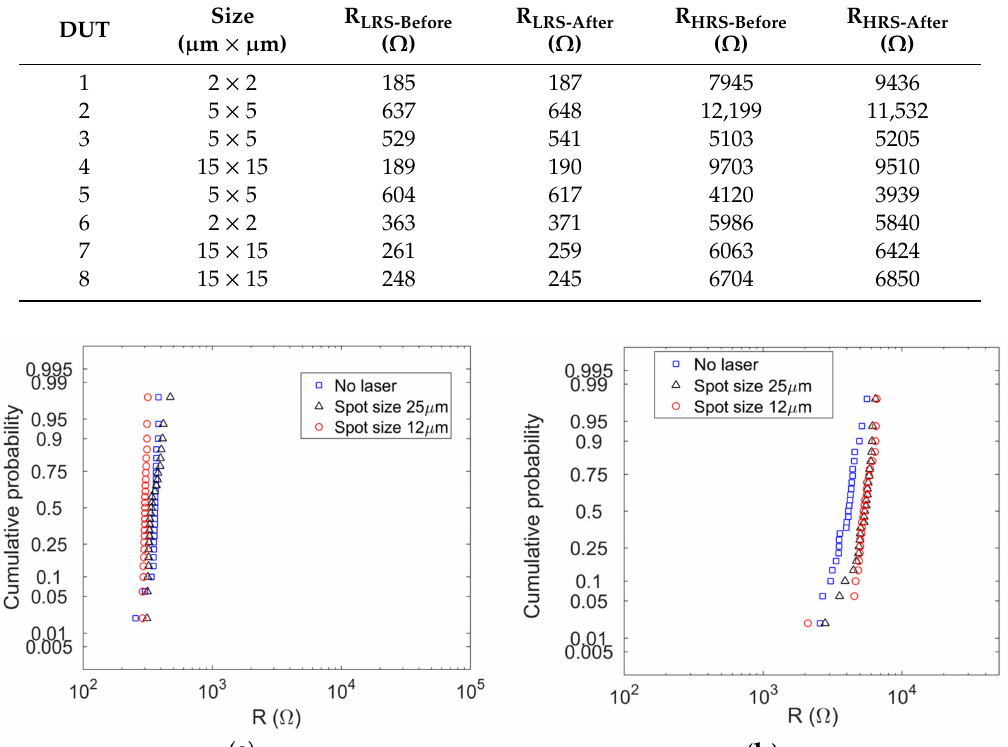
Figure 6. Cumulative distributions ( a ) of the resistance values for a single RRAM (15 × 15 µ m 2 ) before and after a single laser pulse; and ( b ) of the average resistance for 8 RRAMs of di ff erent sizes (152 devices of 2 × 2 µ m 2 , 3 of 5 × 5 µ m 2 and 3 of 15 × 15 µ m 2 ) before and after a single laser pulse. The spot size is 25 µ m. Table 3. Average resistance for 8 RRAMs of di ff erent sizes before and after a single laser pulse.